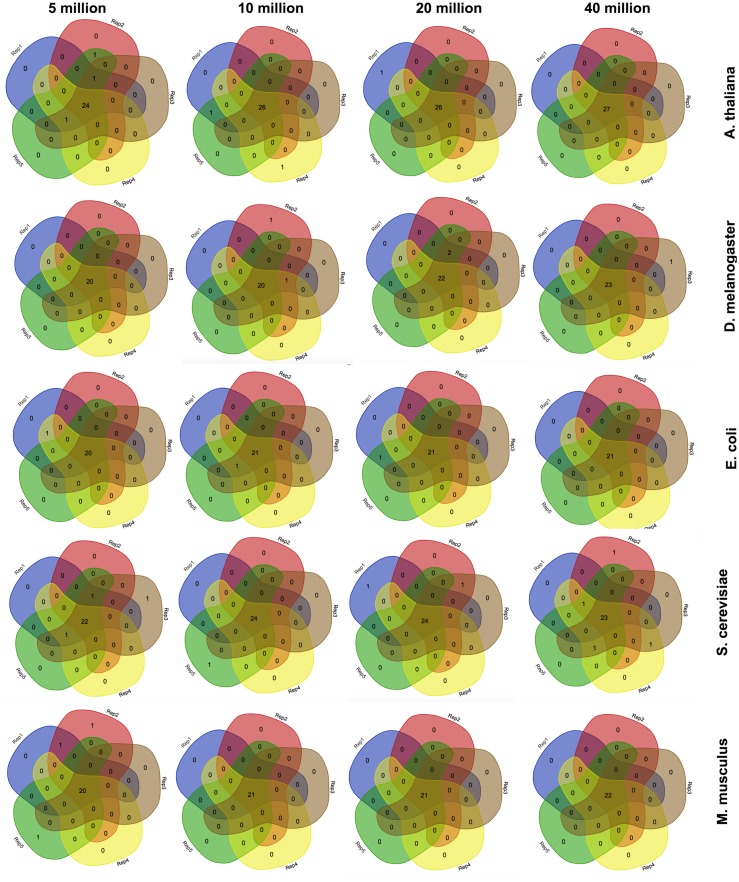
Consistency among replicates.Venn diagrams showing the number of detected favoured codons for five replicates, four values of number of bases and five species. For each presented diagram, each colour region reports the number of codons that were found to be favoured following a corseq run. Overlapping regions reports the number of concordant favoured codons between five replicates for the specified combination of species/number of bases.